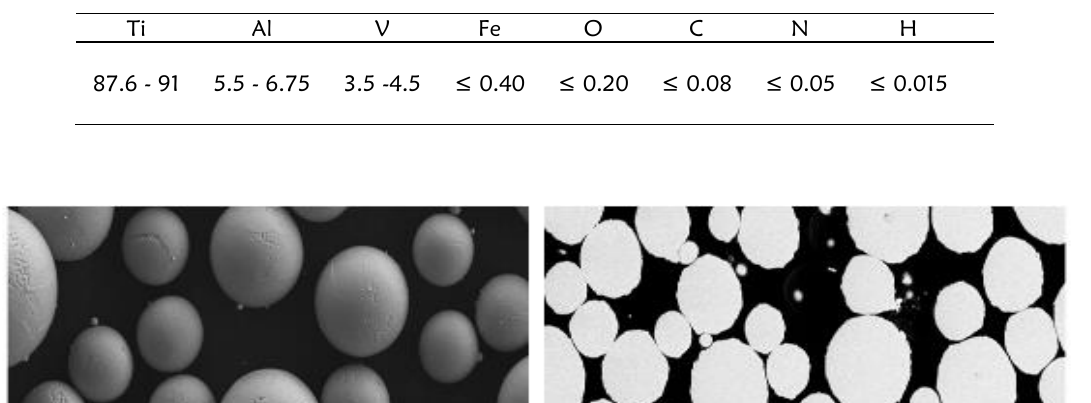
Table 1: Chemical composition w% - Ti6Al4V powder [16].